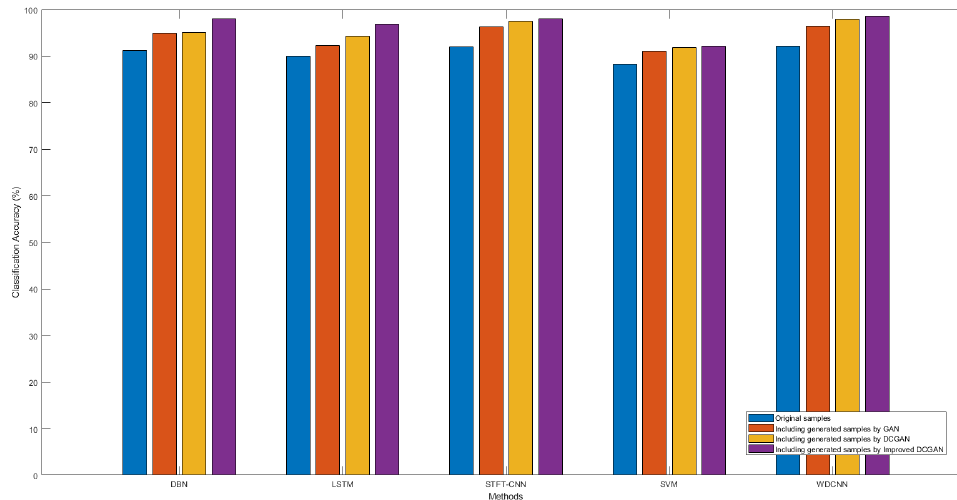
Table 6. Comparison of different diagnostic methods for different datasets.